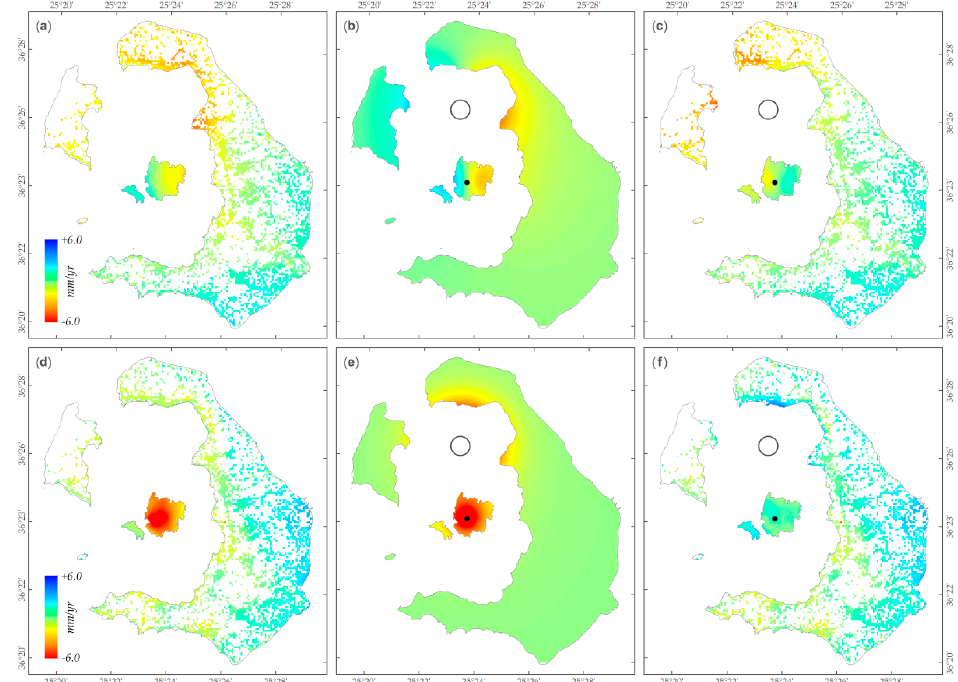
Figure 9. Results from the VSM (Volcano and Seismic source Model) inversion of the four datasets reported in Table 3. Data comparisons concern East-West and vertical components. In the first column are the East-West ( a ) and vertical ( d ) data, in the second column ( b , e ) the model, and in the third column ( c , f ) the residuals, respectively. Black open circle and black dot are the surface projections of the center of the caldera-wide source and the Nea Kameni source, respectively.